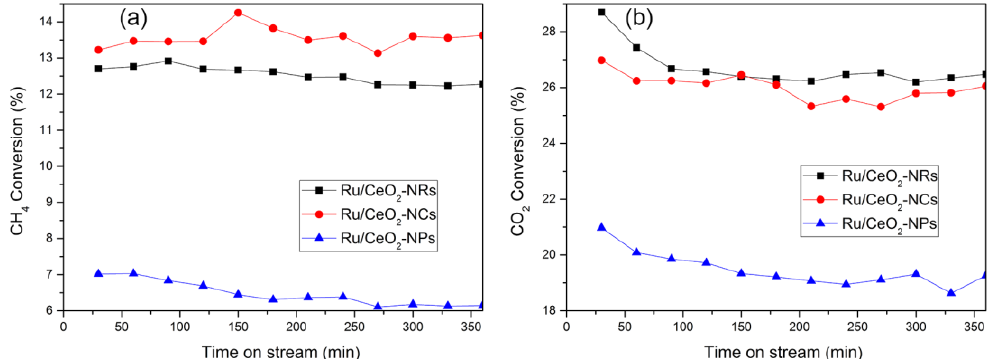
Figure 8. The CH 4 conversion ( a ) and CO 2 conversions ( b ) of three Ru/CeO 2 samples versus time at 500 °C .